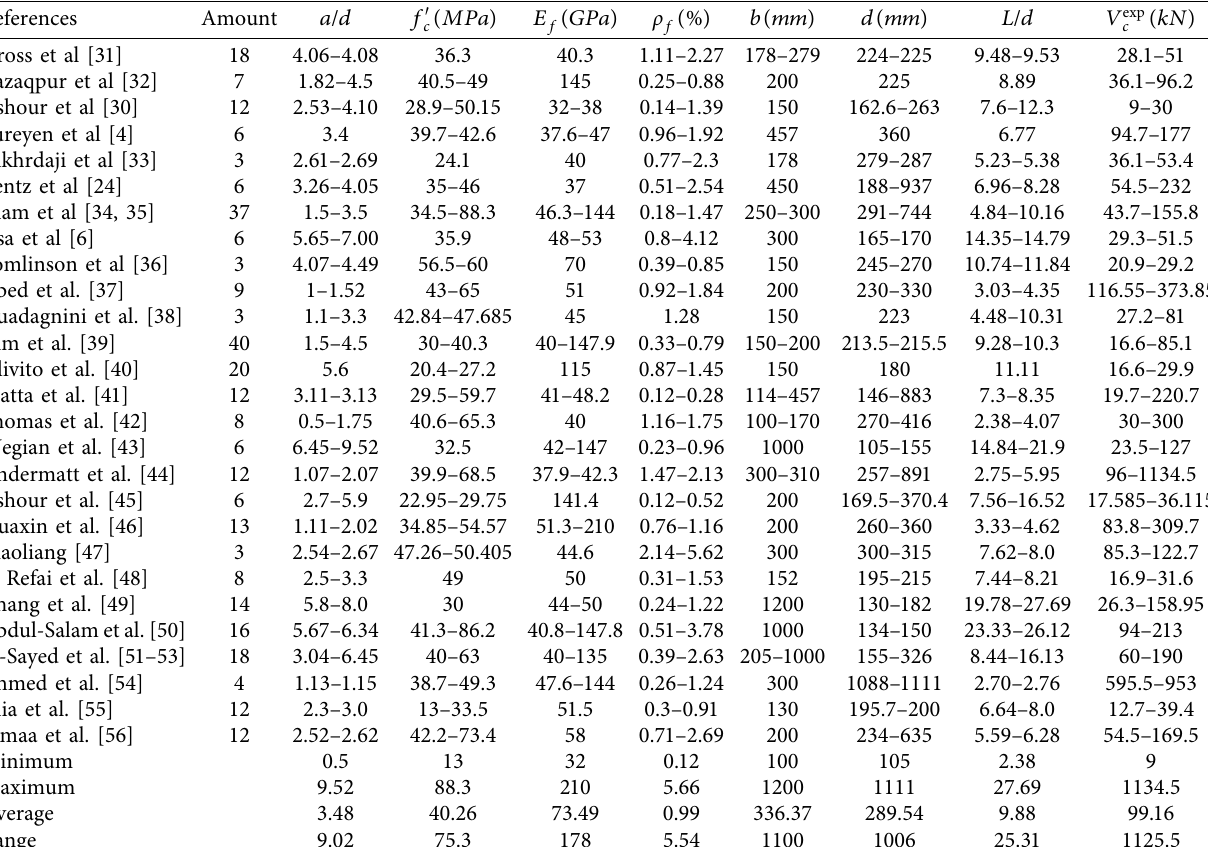
Table 3: Database of parameters of test